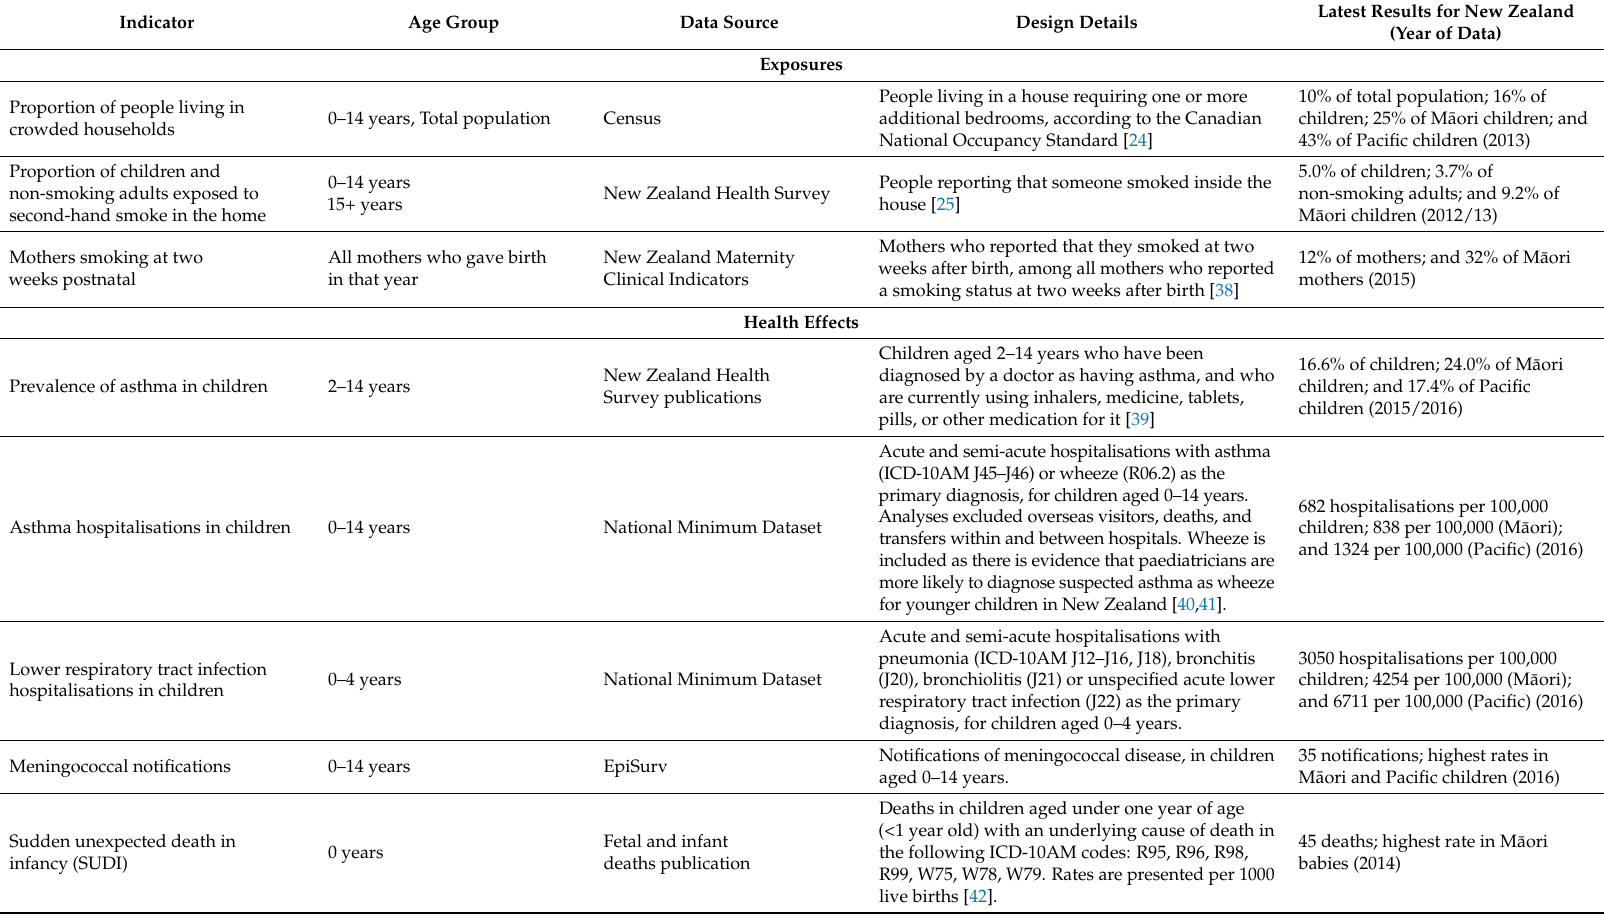
Table 6. Final set of core environmental health indicators for indoor